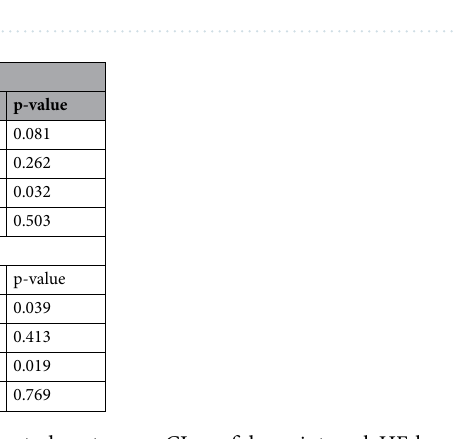
Table 2. Adjusted and unadjusted HR for the study outcomes. CI, confidence interval; HF, heart failure; HR, hazard